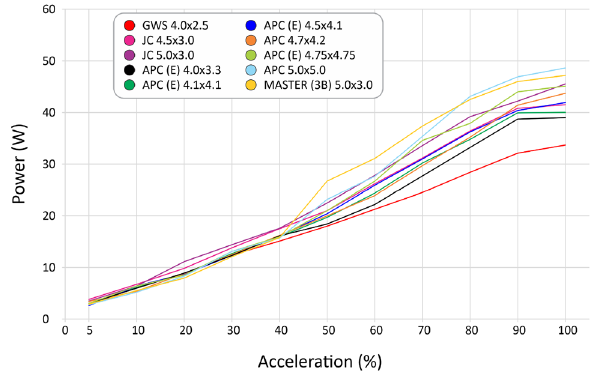
Figure 33. Curves of electrical power consumed with the use of each propeller as a function of acceleration.